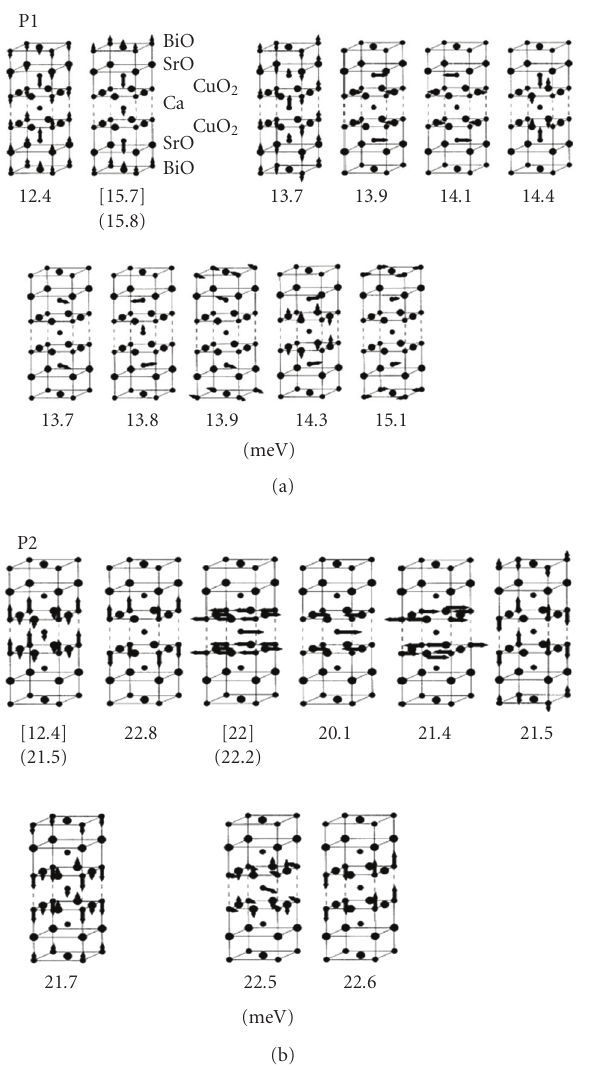
Figure 26: Atomic polarization vectors and their frequencies (in meV) at special points in the Brillouin zone. The larger closed circles in the lattice are O-ions. Γ − X is along the Cu-O-Cu direction. Arrows indicate displacements. The modes in square and round brackets are the transverse and longitudinal optical modes, respectively. (a) Modes of the P1 peak. (b) Modes of the P2 peak. From [46, 47, 53, 54].